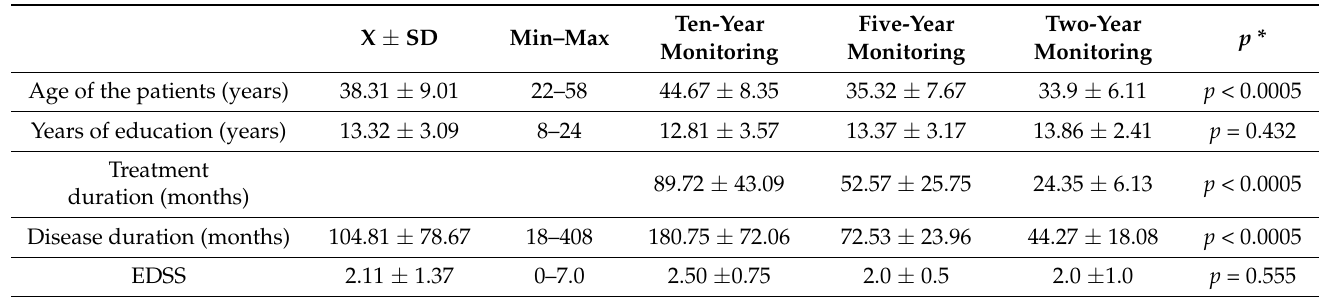
Table 2. Demographic and clinical characteristics of patients monitored for 10 years, 5 years or 2